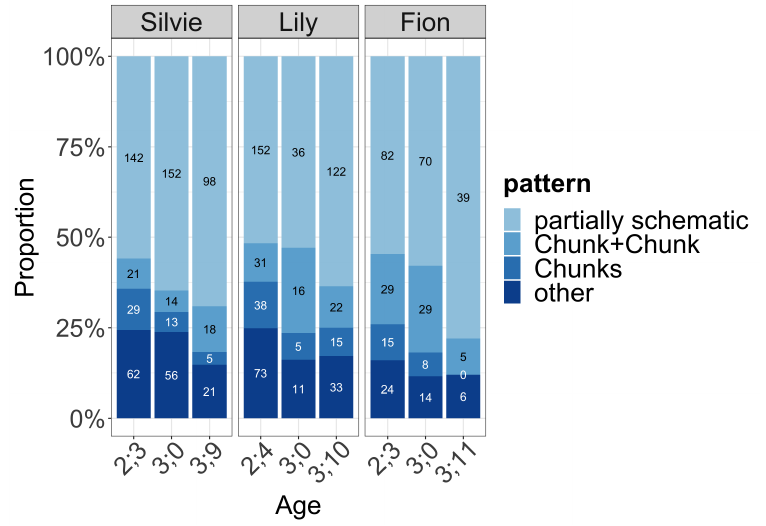
Figure 1. Patterns found in child bilingual code-switching.